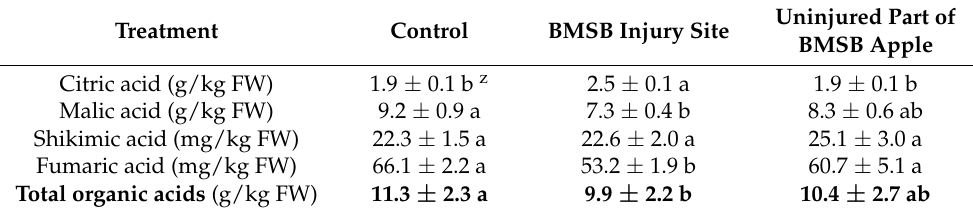
Table 2. Individual and total organic acid contents (mean ± SE) in